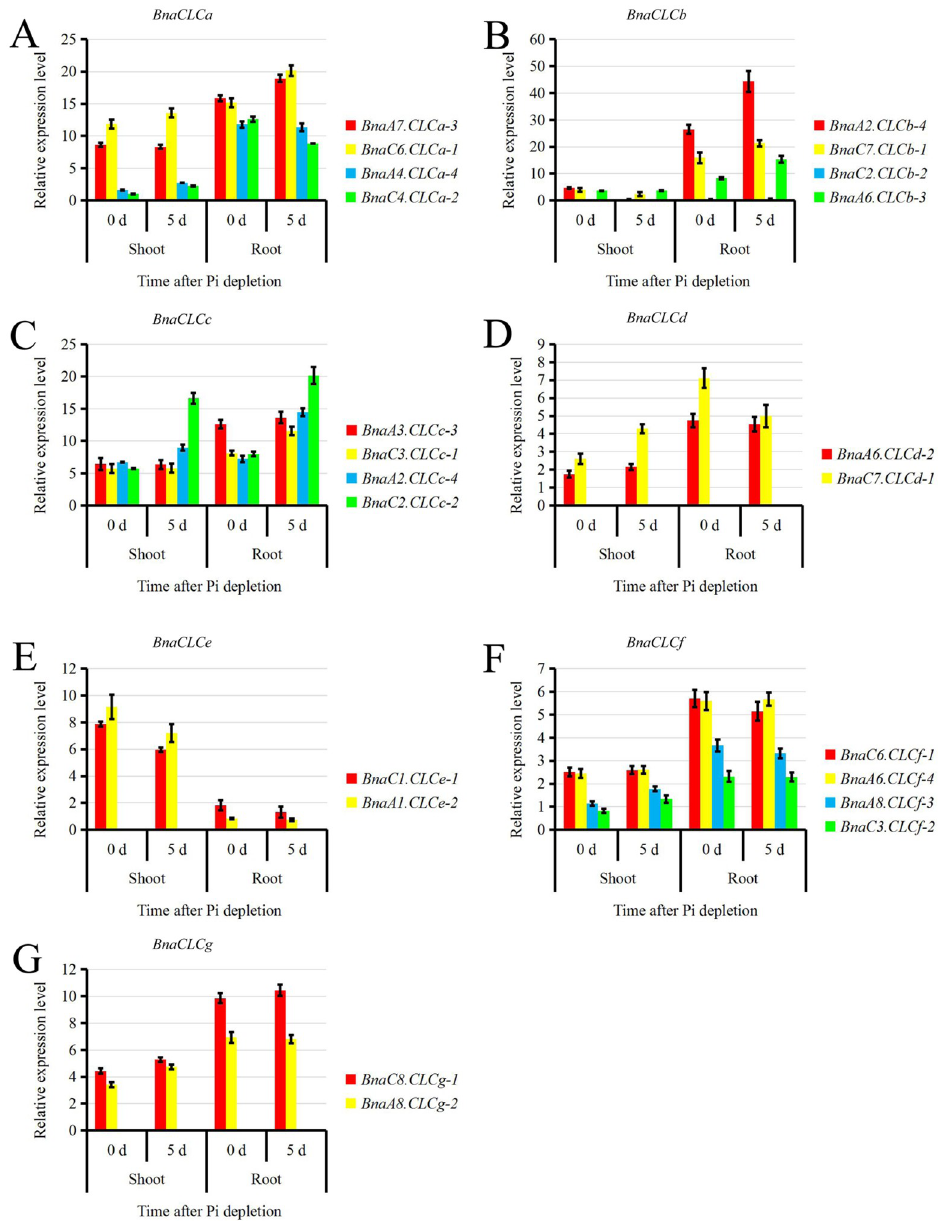
Fig 8. Relative expression of the BnaCLC family members under phosphate (Pi) depletion. Relative expression levels of BnaCLCa (A), BnaCLCb (B), BnaCLCc (C), BnaCLCd (D), BnaCLCe (E), BnaCLCf (F), and BnaCLCg (G), as revealed by the qRT-PCR assays. For the Pi starvation treatment, the rapeseed seedlings were first grown under 250 μ M Pi (KH 2 PO 4 ) for 10 d, and then transferred to a Pi-free solution for 5 d. Bars indicate the standard deviation (SD) of three biological